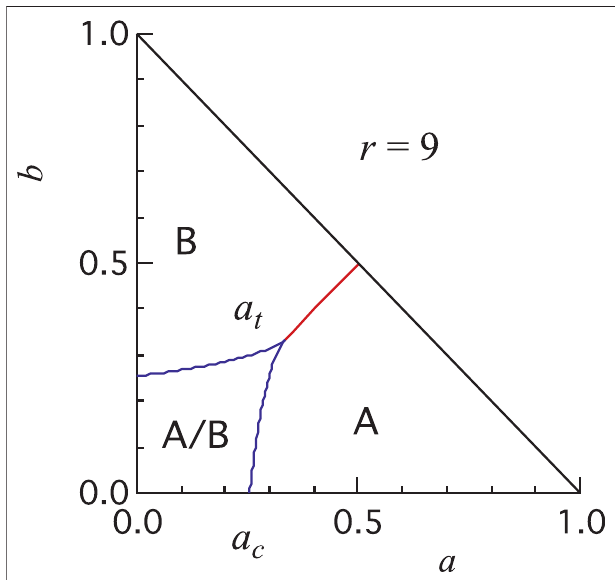
FIGURE 7 | An example of the phase diagram of the parameter space { a , b } . The group size here is chosen to be r (cid:2) 9. The regions marked as A , B , and A / B represent parameter values with which the system converges unconditionally to A majority, unconditionally to B majority, and to either A or B majority depending on the initial con fi guration, respectively.